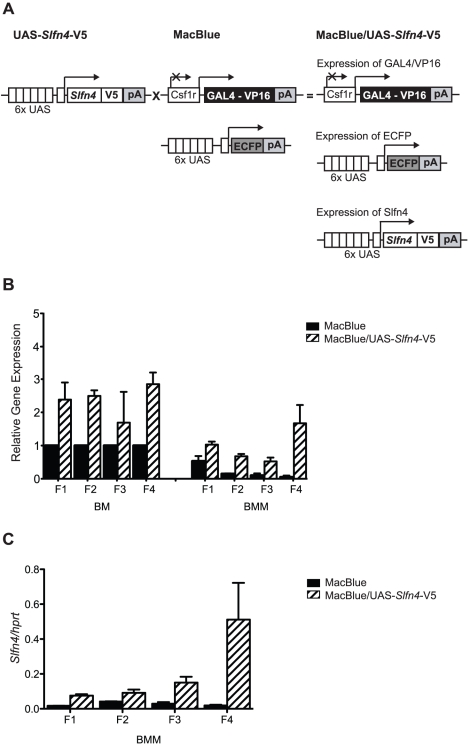
Macrophage-specific expression of the UAS-Slfn4-V5 transgene.(A) Elements of the UAS-Slfn4-V5 transgene include six UAS, a kozak sequence, and the open reading frame of Slfn4 followed by a V5-tag. Upon crossing of the UAS-Slfn4-V5 mouse with the MacBlue mouse, the offspring (MacBlue/UAS-Slfn4-V5 mice) contain the GAL4-expressing module, the GAL4-reporting module, and the UAS-Slfn4-V5 transgene. GAL4/VP16 protein binding to both the UAS induces the expression of ECFP and Slfn4-V5 specifically in cells of the myeloid lineage. (B and C) RNA from bone marrow (BM) or BMM from the offspring of four UAS-Slfn4-V5 founder lines (F1–F4) was extracted and cDNA was prepared. Slfn4 mRNA levels relative to hprt were determined by quantitative real-time PCR. Data are combined from at least two independent experiments (mean + range) and are presented as expression relative to BM controls to enable normalization across different the transgenic lines (B), or as expression relative to hprt (no normalization across the transgenic lines) (C).